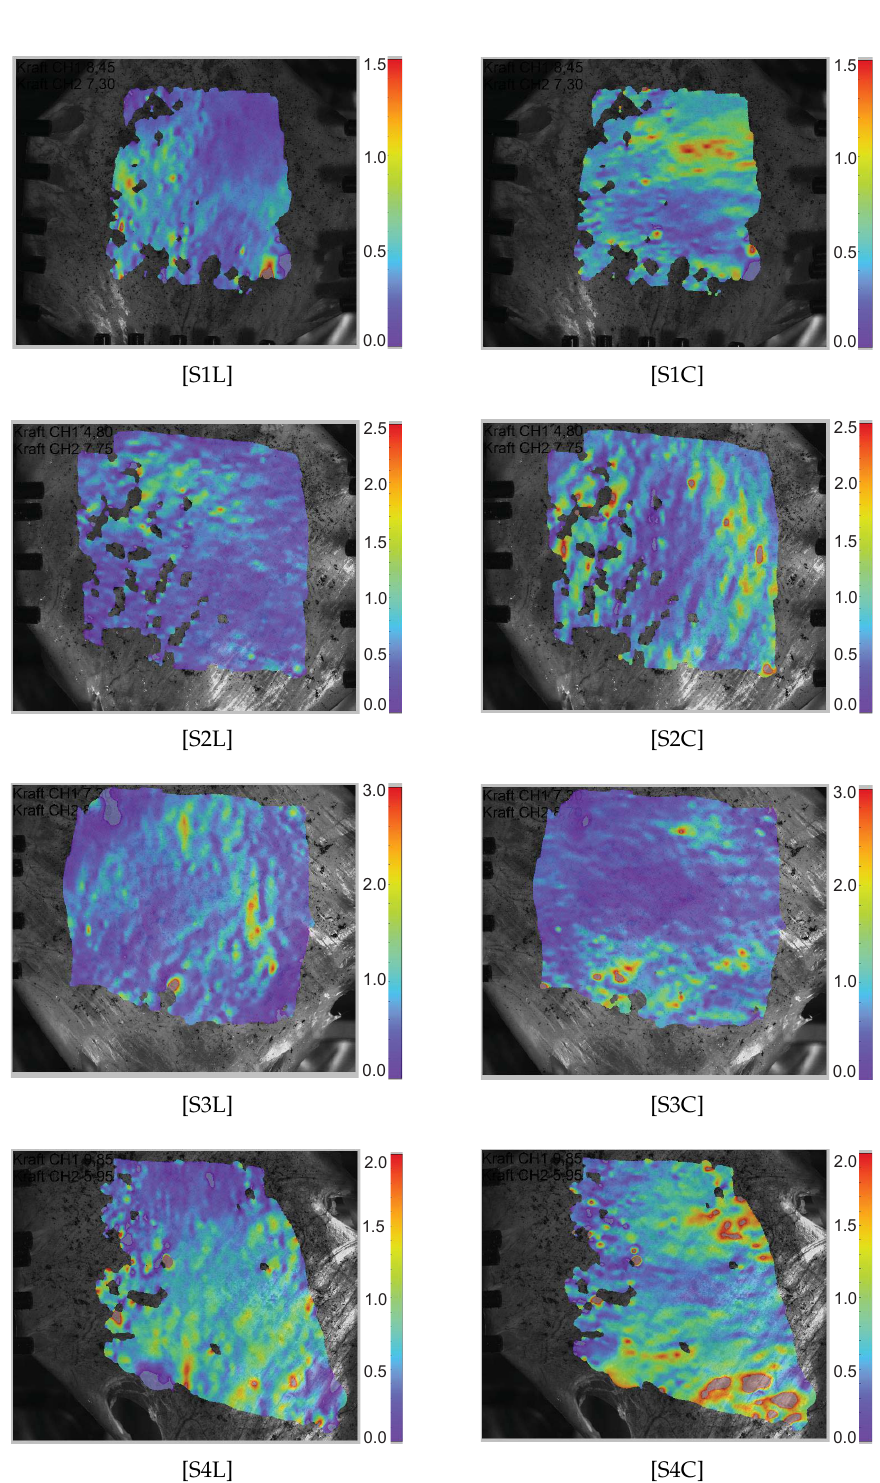
Figure 4. Green–Lagrange strain heat maps (E LL ,E CC ) measured along the longitudinal and the circumferential direction in the specimens. “S i L” represents the i th specimen along the longitudinal direction, whereas “S i C” represents the i th specimen along the circumferential